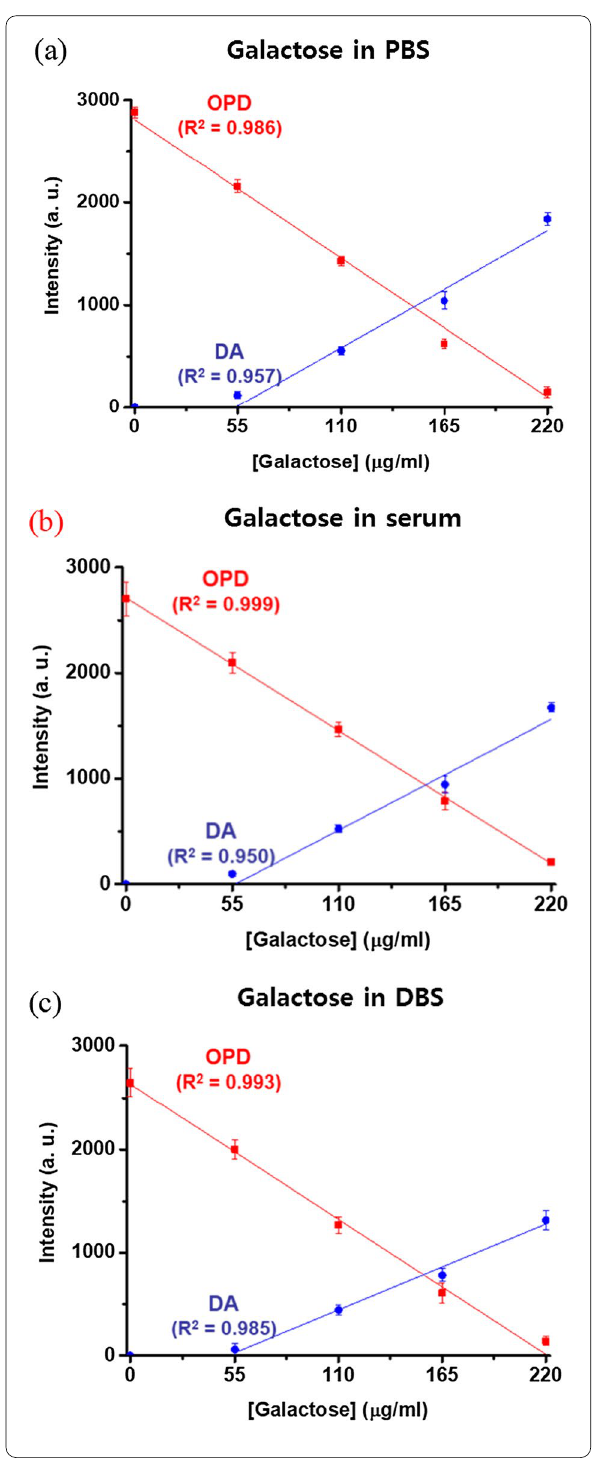
Fig. 3 Quantitative analysis of galactose using MALDI‑TOF MS based on the TiO 2 nanowire chip. a Mass spectra of OPD assay products with different galactose concentrations in PCB. Correlation between the intensities of mass peaks of OPD and DA and the concentration of galactose. b Correlation between the intensities of mass peaks of OPD and DA and the concentration of galactose in serum after methanol extraction. c Correlation between the intensities of mass peaks of OPD and DA and the concentration of galactose in DBS after methanol